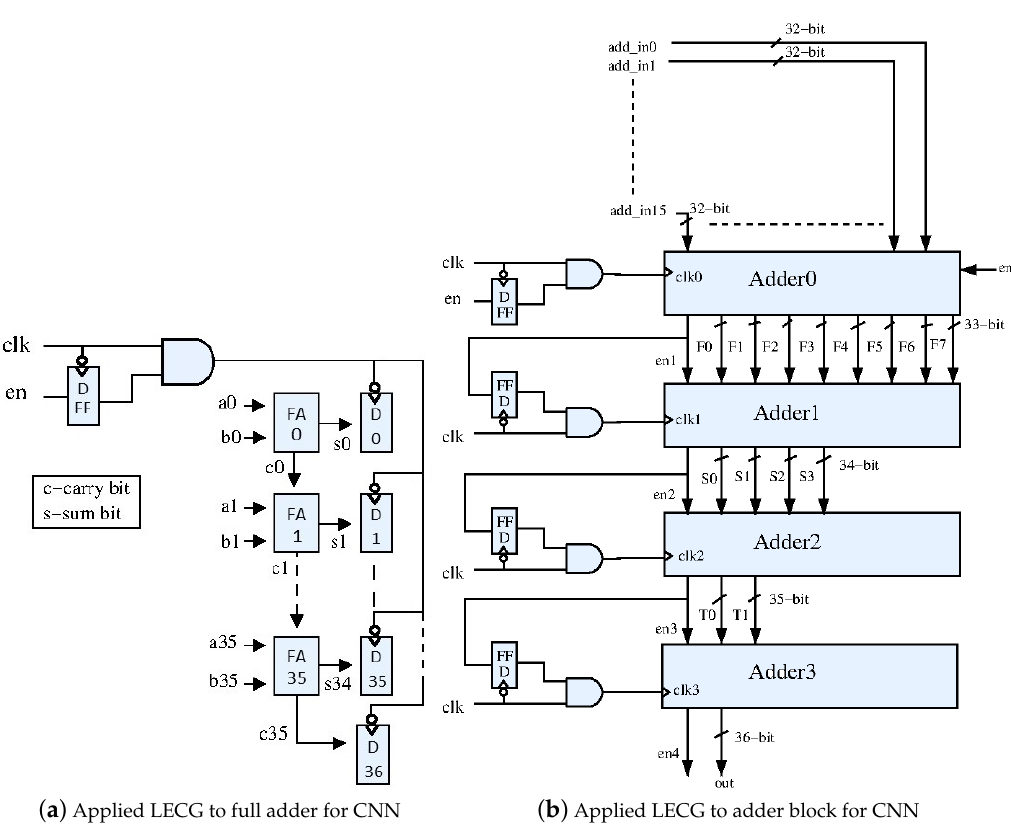
Figure 9. Applied local explicit clock gating (LECG) technique.